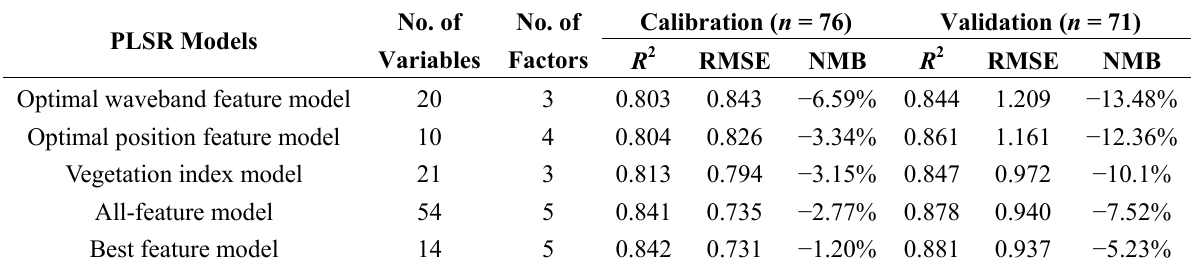
Table 7. Performance of the PLSR models in predicting LAI based on the use of different datasets. NMB, normalized mean bias.